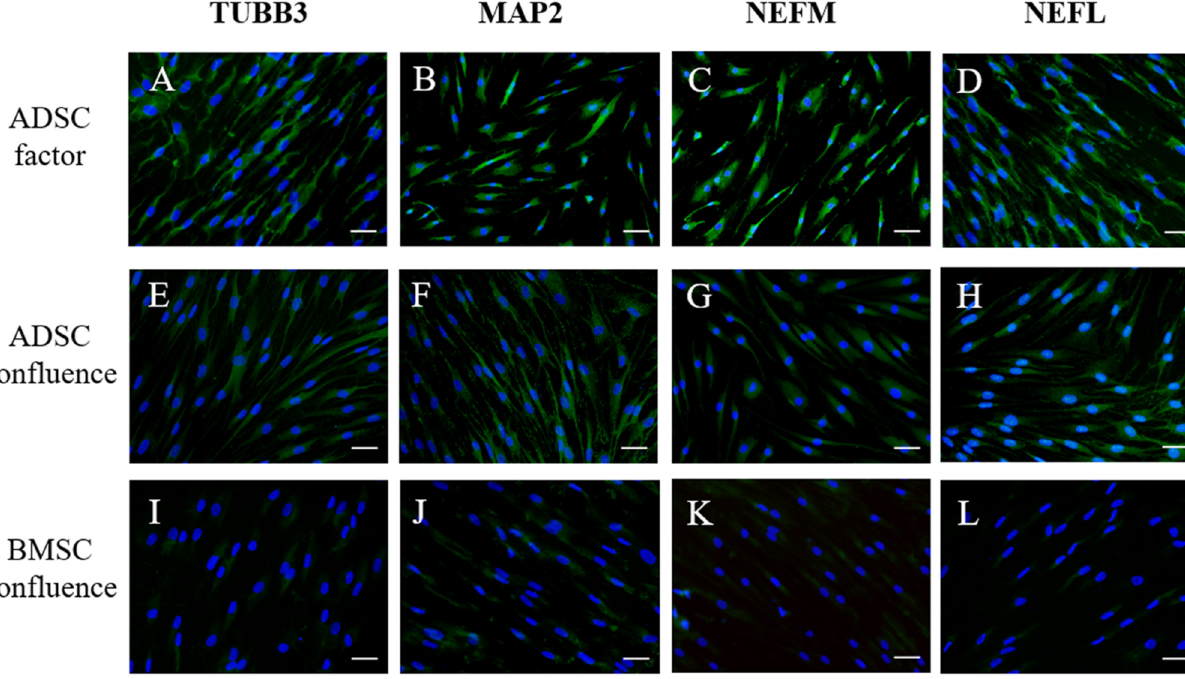
Figure 3. Comparison of neuron-related protein expressions of the ADSCs and BMSCs during confluence-initiated neuro- genic differentiation. ( A , E , I ) Class Ⅲ β -tubulin (TUBB3), ( B , F , J ) microtubule-associated protein 2 (MAP2), ( C,G , K ) neu- rofilament medium polypeptide (NEFM), and ( D , H , L ) neurofilament light polypeptide (NEFL) of the factor-induced AD- SCs, confluence-initiated ADSCs, and confluence-initiated BMSC differentiated neuron-like cells on day 7 detected by immunofluorescence staining are shown in green fluorescence. DNA stained by DAPI is shown in blue fluorescence (mag- nification × 100; the scale bar = 100 μ m). ( M ) The mean of the total immunofluorescence intensity from a fixed number of cells in six fields of one slide was quantified by the Image-Pro Plus v4.5.0.29. ( N ) The mean of the value that was normal- ized to the cell numbers in the field was calculated. All the values are expressed as mean ± S.D. with three experimental replicates. Statistical significance to compare the multiple groups was determined using one-way ANOVA analysis. “*” represents p < 0.05. “**” represents p < 0.01.